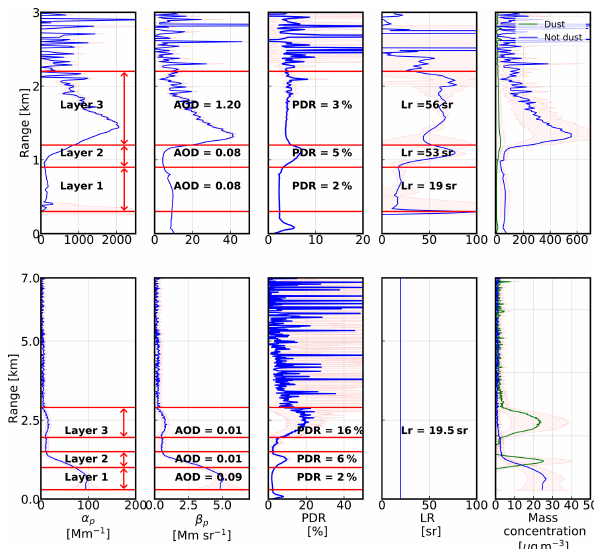
Figure 13. Optical properties and mass concentration estimates cal- culated from lidar signals. Top row: warm sector, Watnall on 16 Oc- tober from 11:15 to 11:44UTC. Bottom row: cold sector (Fernald– Klett method), Watnall on 16 October from 14:30 to 15:00UTC.